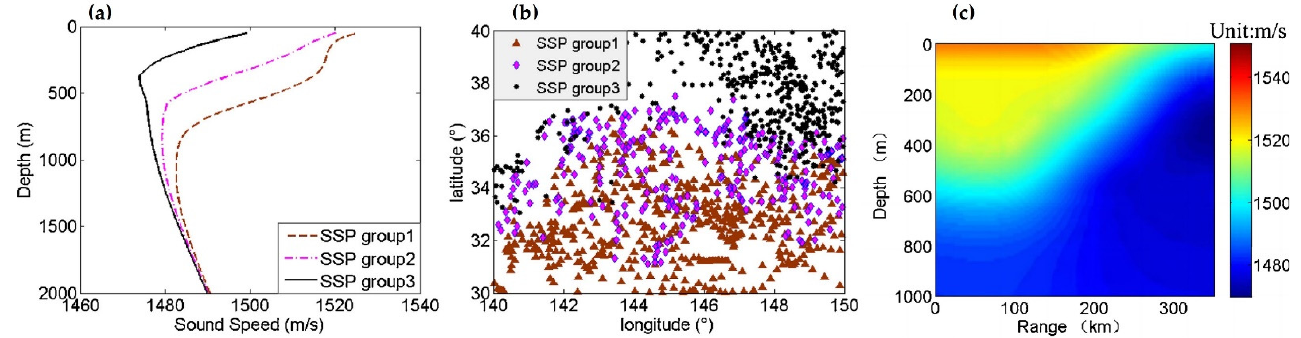
Figure 4. Results of cluster analysis and the KEF sound speed characteristic model [20]: ( a ) major feature of the three kinds of SSP; ( b ) spatial distributions of the three SSP groups; and ( c ) the KEF sound speed characteristic